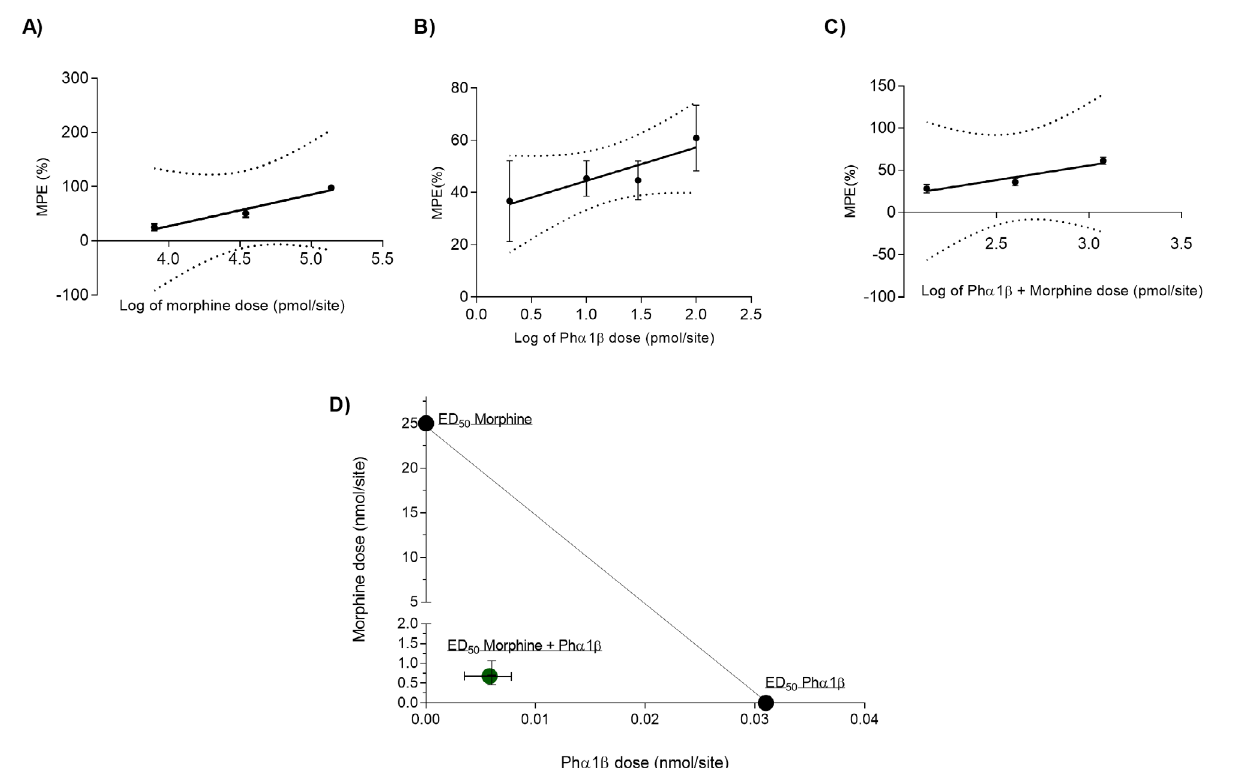
Figure 4. Dose-response analyses of morphine, recombinant Phα1β, and their combination of melanoma-induced mechanical hypersensitivity. (A) Linear regression data for increasing concentrations of morphine, (B) recombinant Phα1β, (C) and their combination in the antinociceptive effect on melanoma-induced mechanical hyperalgesia. Points express the mean ± S.E.M. of the normalized responses given in maximum possible effect (MPE%). Regression lines with their respective 95% of morphine (y-axis) plotted against Phα1β (x-axis). The confidence intervals are also shown (doted lines). n = 4-7 animals per dose. (D) Isobologram for the ED 50 points over the axis denote the ED of Phα1β and morphine administered alone. The line connecting the ED values is the theoretical additive line. The point inside 50 50 the graph denotes the experimentally obtained ED